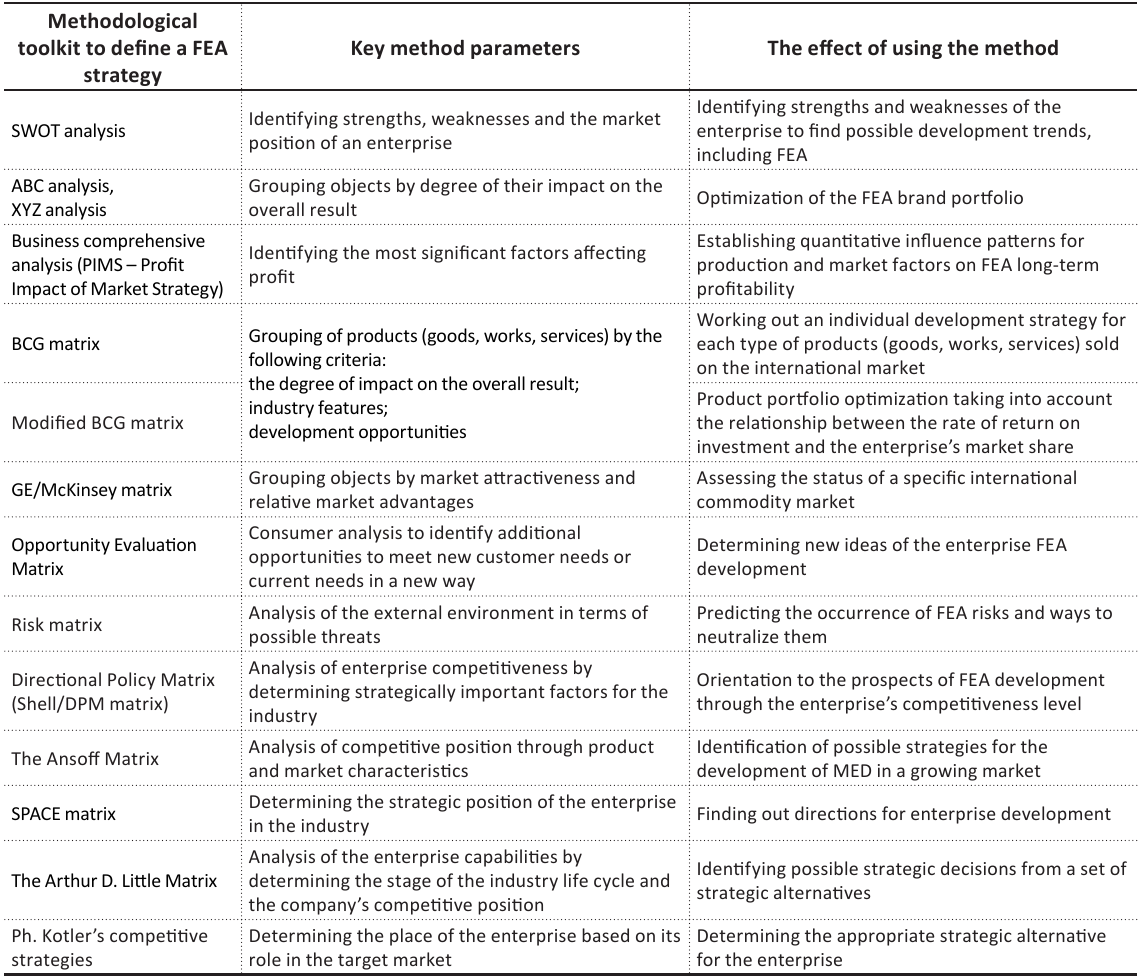
Table 1. Methods of strategic analysis of the enterprise’s foreign economic activity